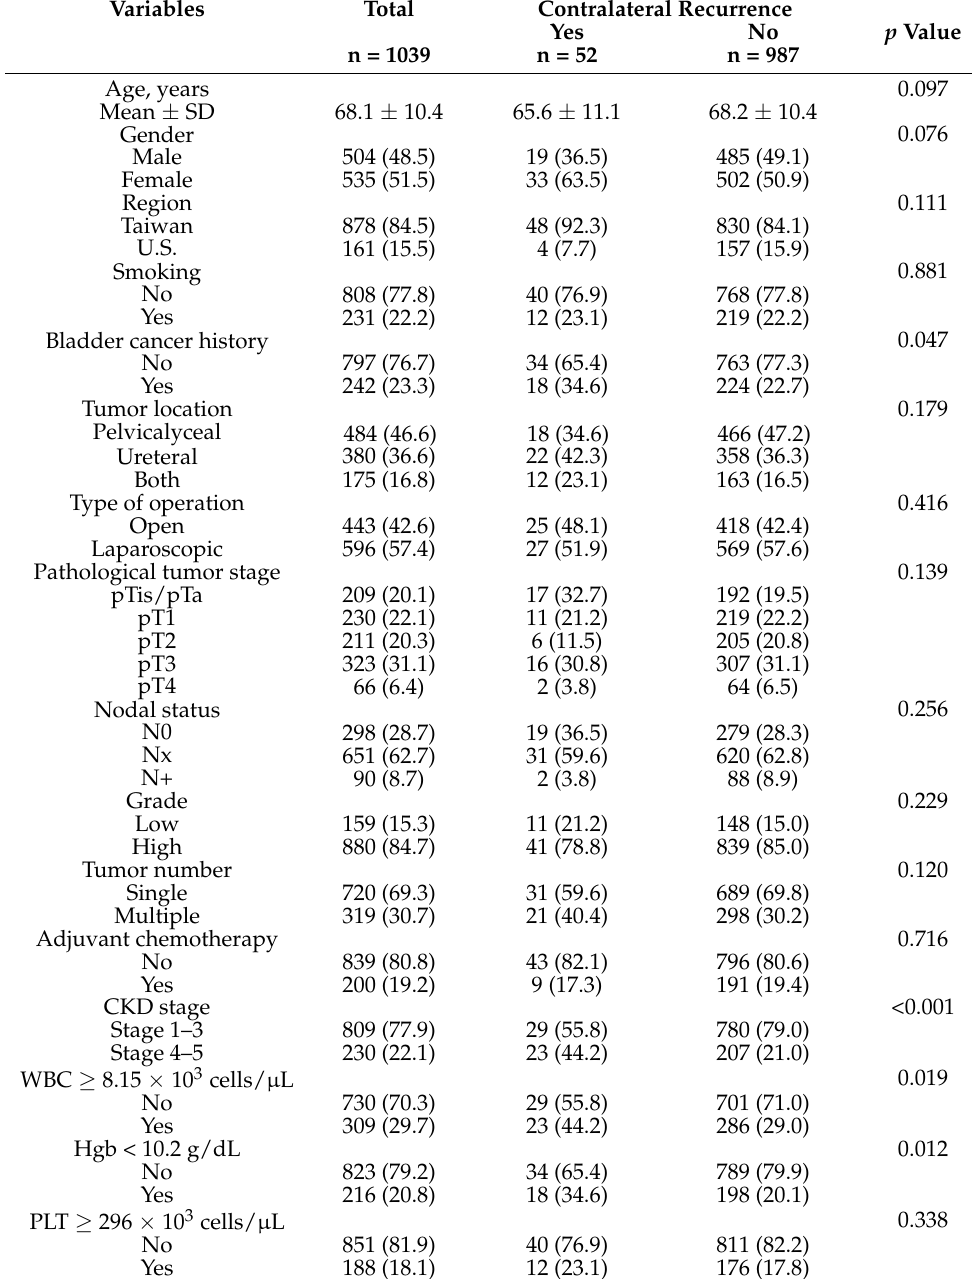
Table 1. Demographics and clinicopathological characteristics of the 1039 patients with upper tract urothelial carcinoma (UTUC) according to contralateral